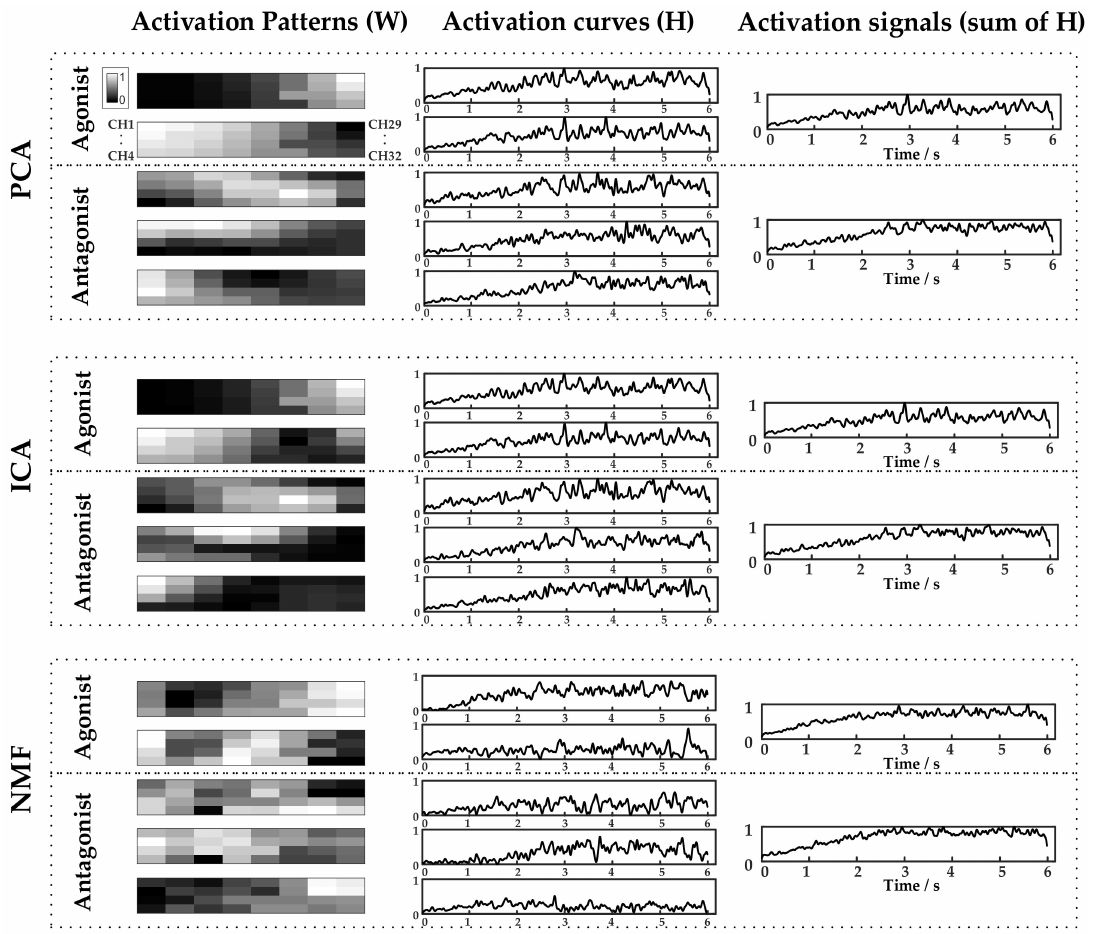
Figure 3. HD-SEMG decomposition and activation signal extraction results obtained via PCA, ICA, and NMF algorithms for Subject 1 during 40% MVC elbow flexion